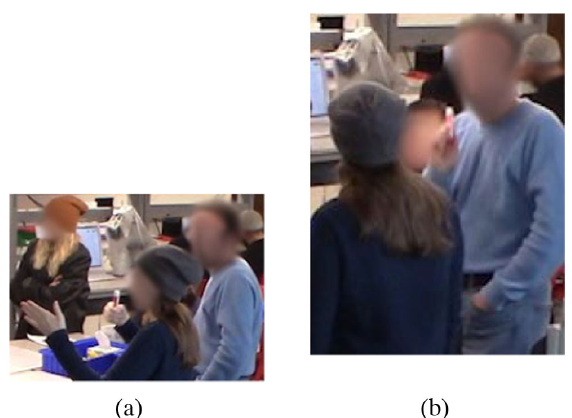
FIG. 1. Group ’ s embodied action during explanation building. (a) Lisa punching fist into open hand, representing a microsphere- microsphere collision (see line 3166) and (b) LA throwing a marker at Lisa, representing a fluid particle running into a microsphere (see line